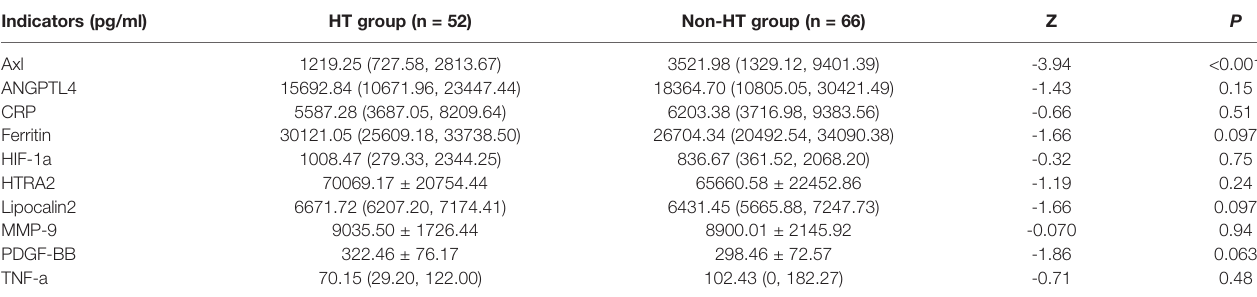
TABLE 2 | Results of the Human Cytokine Antibody Array. Indicators (pg/ml)